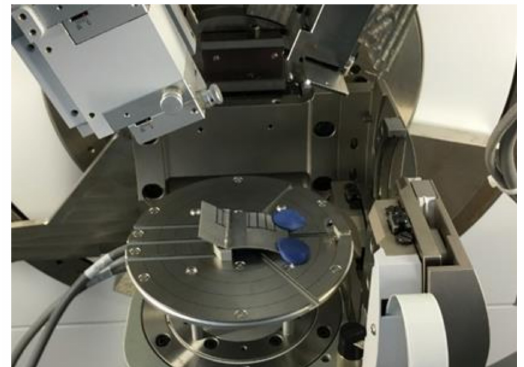
Figure 3. Illustration of the sample regions where residual stress were measured.